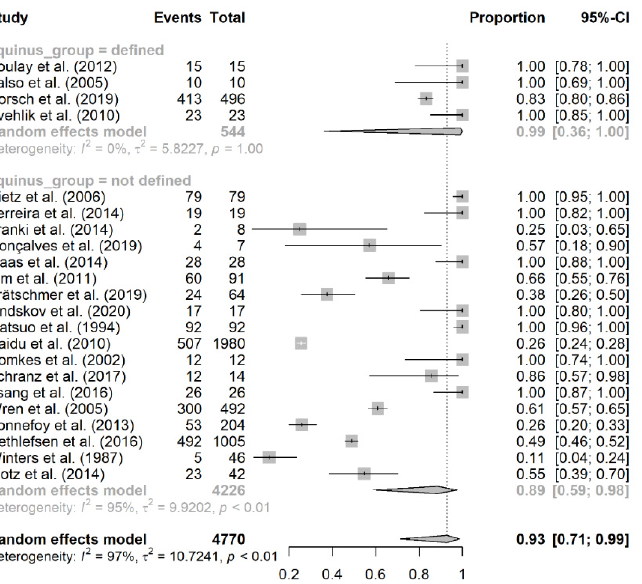
Figure 5. Subgroup analysis of equinus foot prevalence based on the presence/lack of definition criteria for equinus.